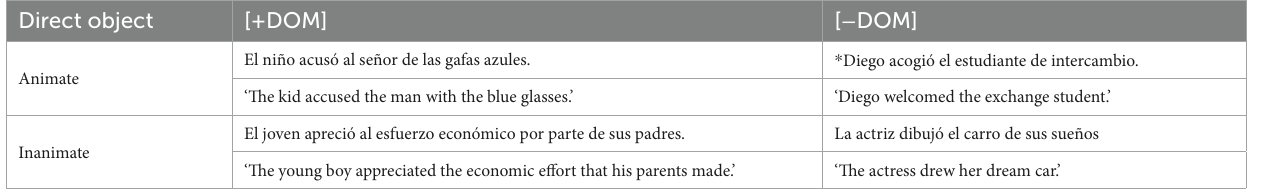
TABLE 5 Sample sentences used in the